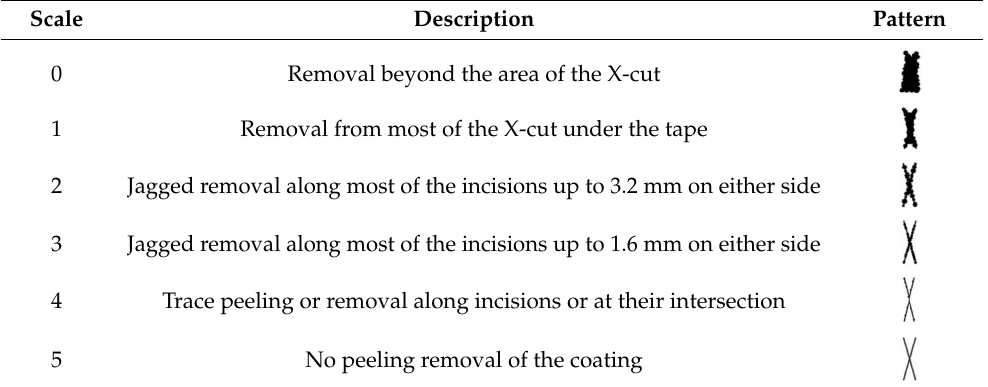
Table 1. Detachment patterns and classification of the coated surface after adherence test (ASTM D 3359).